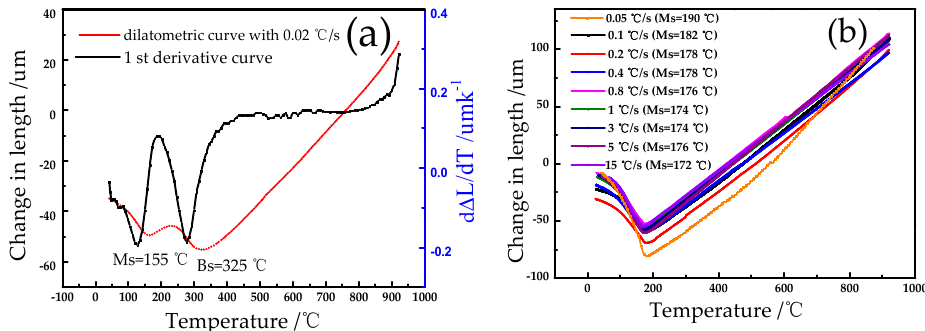
Figure 5. ( a ) The dilatometric curve of the carburised layer at a cooling rate of 0.02 ◦ C/s. ( b ) The dilatometric curve of the carburised layer at the cooling rate range of 0.05–15 ◦